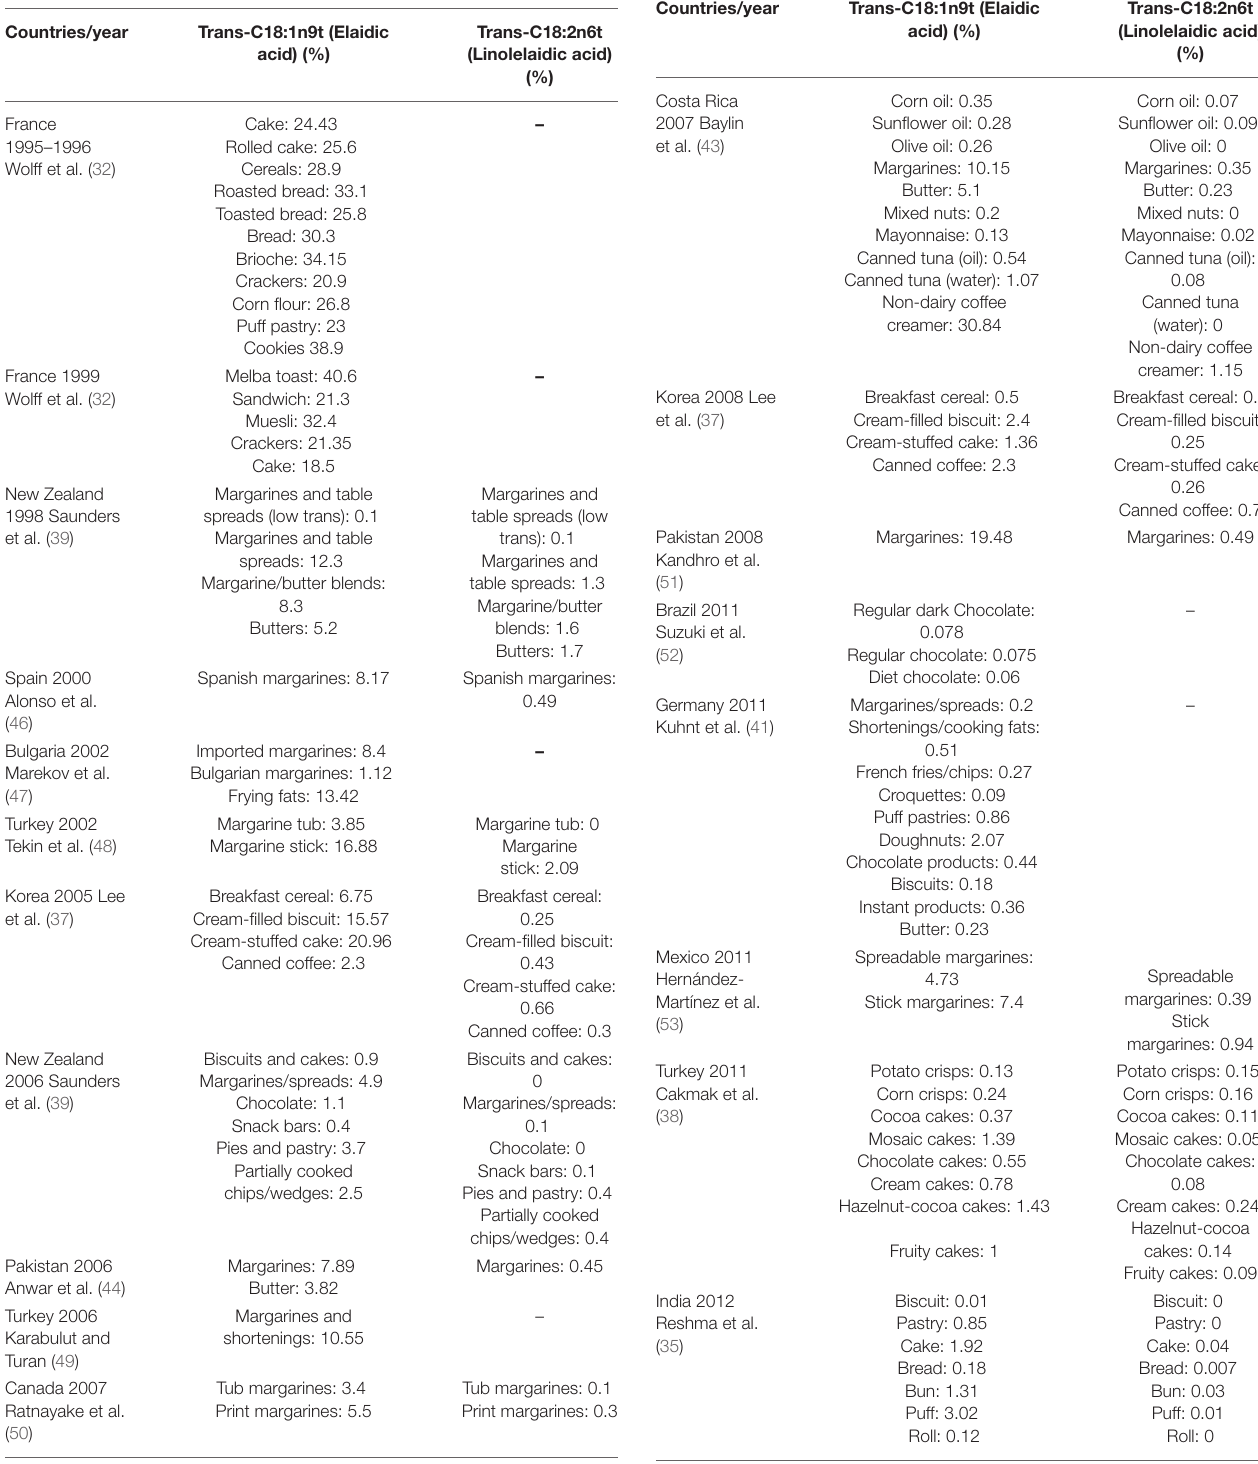
TABLE 5 | Industrially produced trans fatty acids (EA and LEA) in 100g of total fat per food group among different countries. IP-TFAs